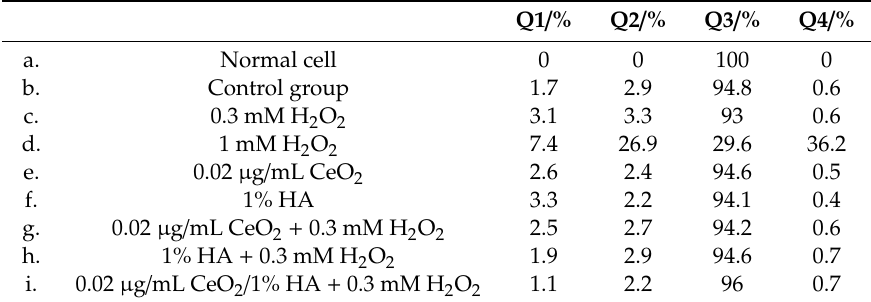
Table 1. The percentage of each quadrant of figures of flow cytometry.